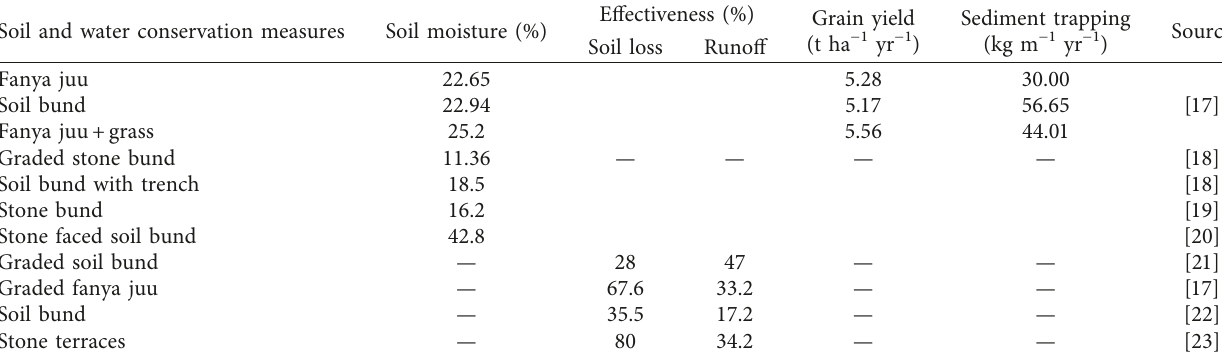
Table 1: Effects of soil and water conservation measures on different parameters.